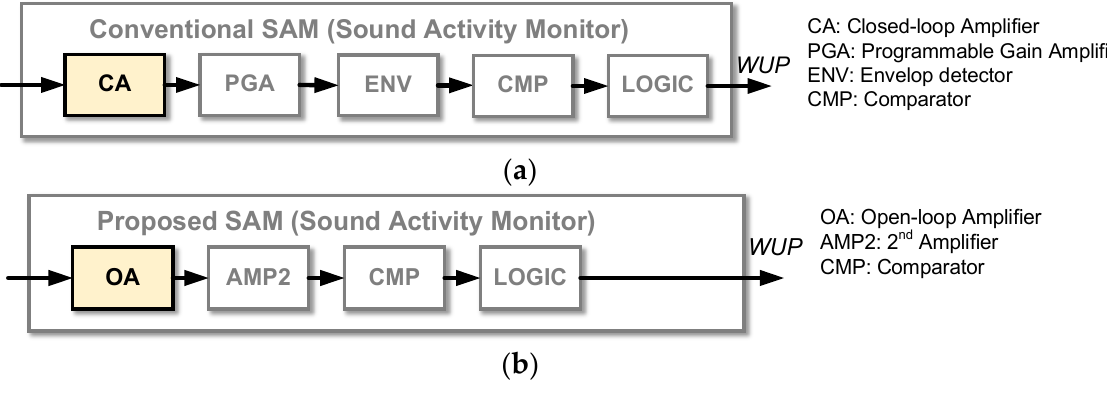
Figure 4. Architecture approach 2: ( a ) Closed-loop amplifier(CA) vs. ( b ) Open-loop amplifier(OA).